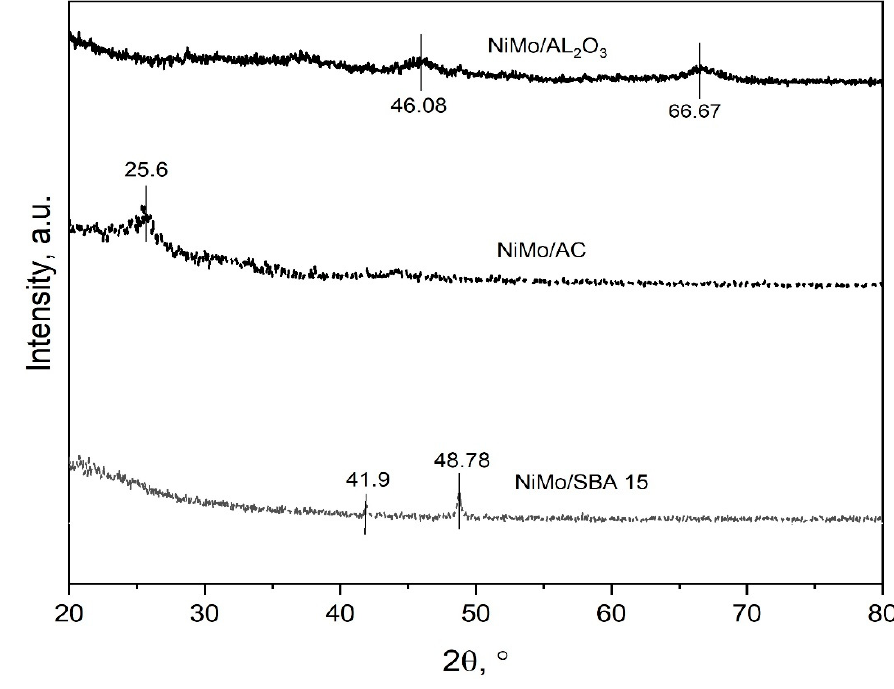
Figure 3. X-ray di ff raction (XRD) di ff ractogram of the NiMo Figure 3. X-ray diffraction (XRD) diffractogram of the NiMo catalysts.